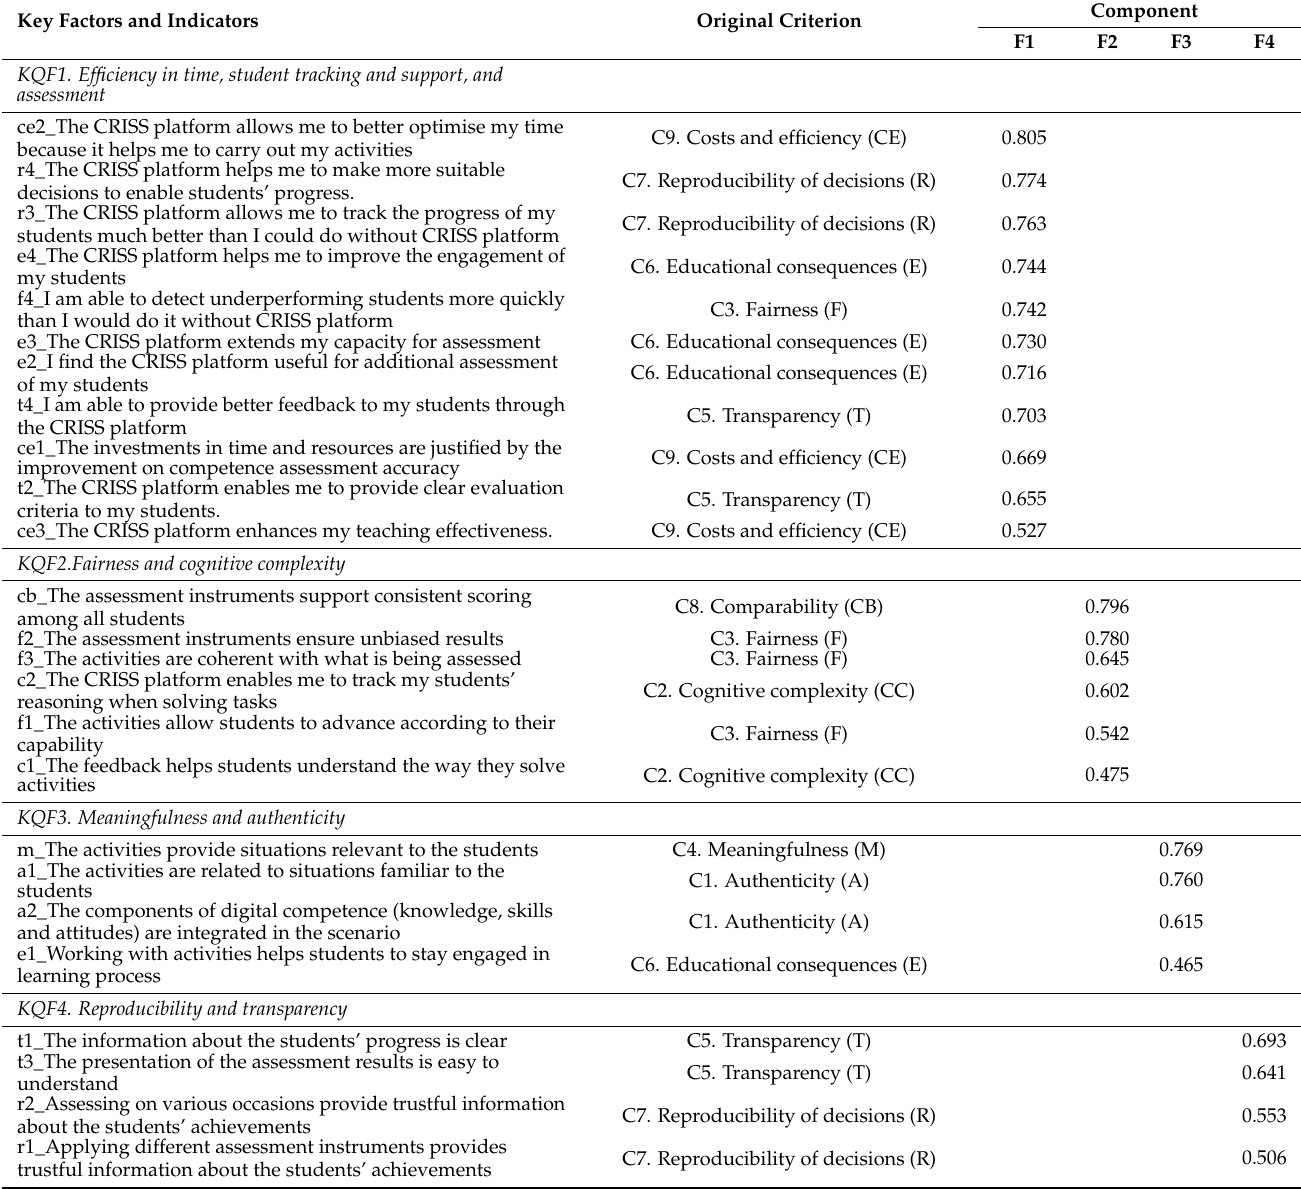
Table 7. Rotated component